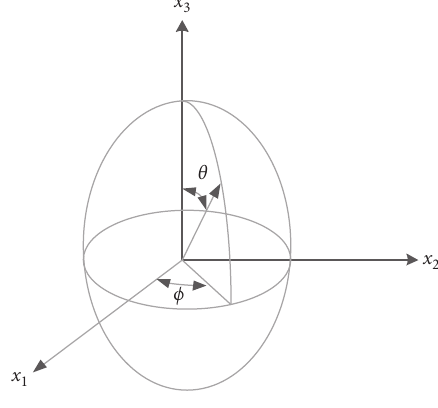
Figure 1: Illustration of